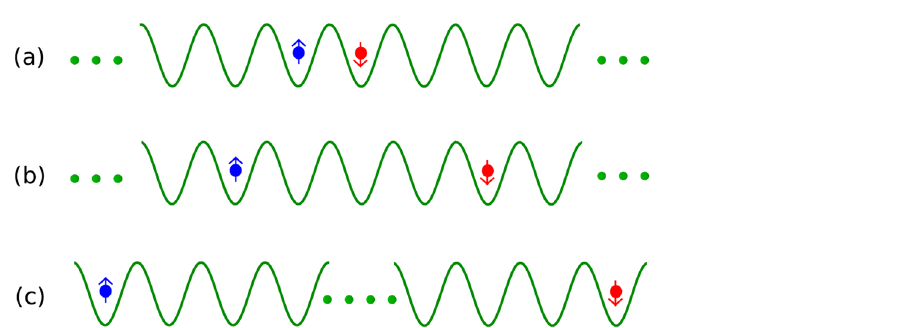
Figure 5. Shows the behaviour of ( a ) P and ( b ) SDI as a function of U for different δ after a time evolution of the initial state given in Eq. (5) up to t = 7 J − 1 .